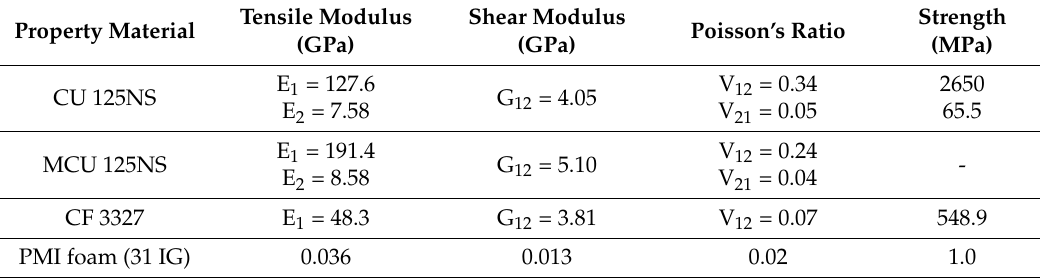
Table 2. Mechanical properties of applied